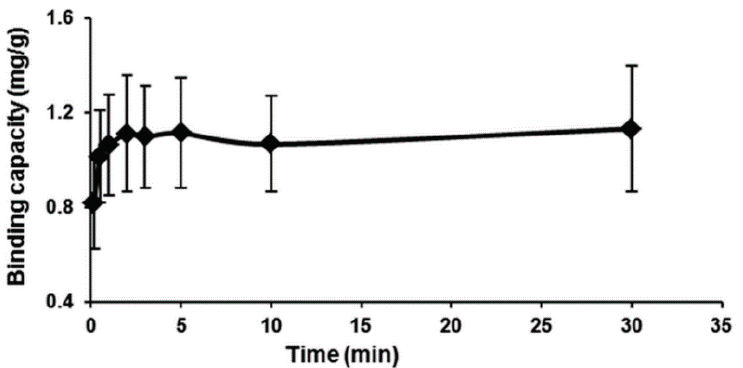
Figure 8. Time-dependent adsorption of Hg(II) ions on the MIP beads (conditions: 50 mL of 2 mg/L Hg(II) ions solution, 50 mg polymer, at pH 7 and 25